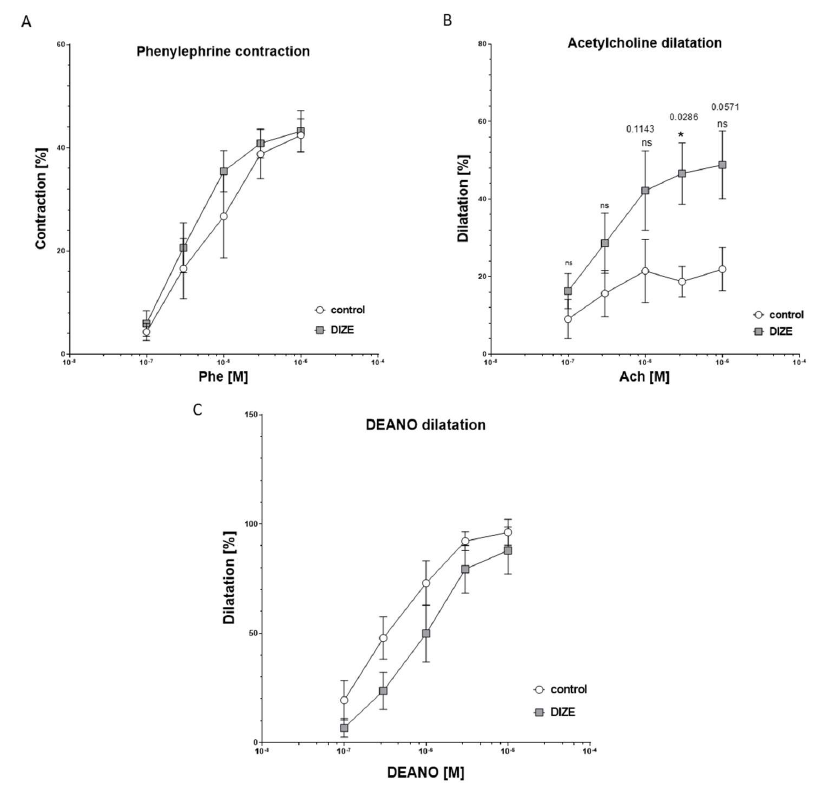
Figure 4. Graphs showing the time course response of mesenteric arteries to phenylephrine ( A ), acetylcholine ( B ), and DEA-NO ( C ) from control and DIZE-treated mice. Data are mean ± SEM analyzed using nonparametric Mann–Whitney U test (* p < 0.05 as compared to control mice; n = 4–6 per group). Int. J. Mol. Sci. 2021 , 22 , x FOR PEER REVIEW